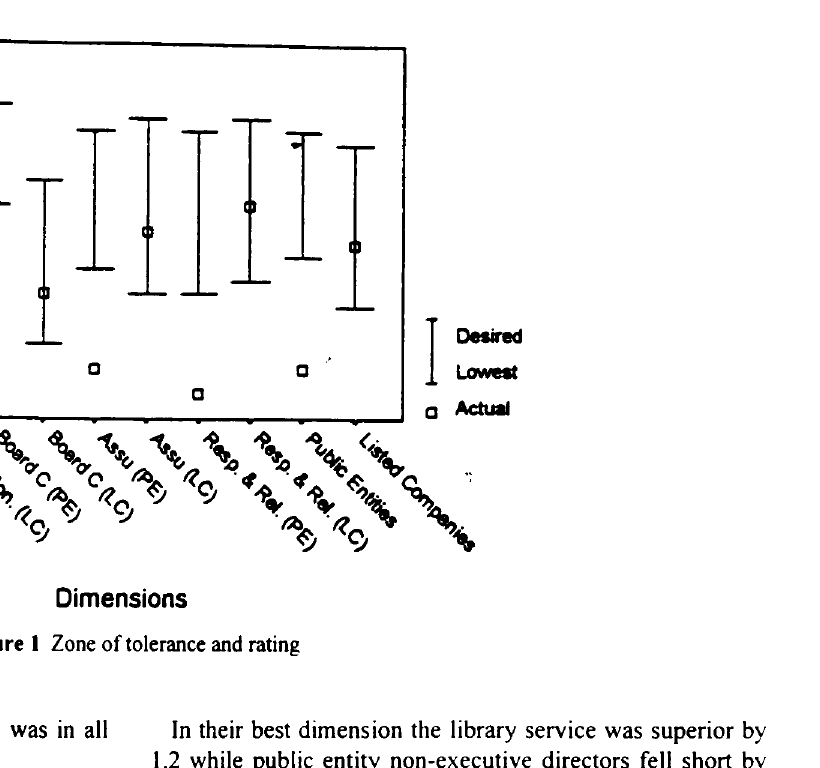
Figure I Zone of tolerance and